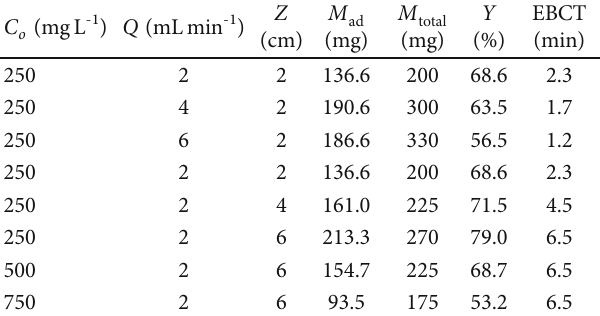
Table 1: Fixed-bed column parameters for the adsorption of Pb 2+ ions by